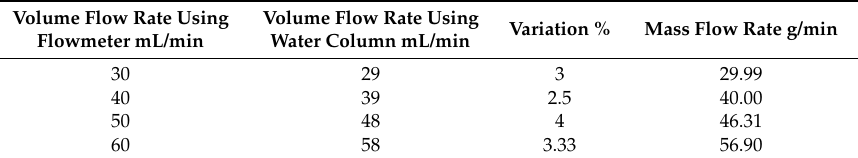
Table 4. The volume and mass flow rates of